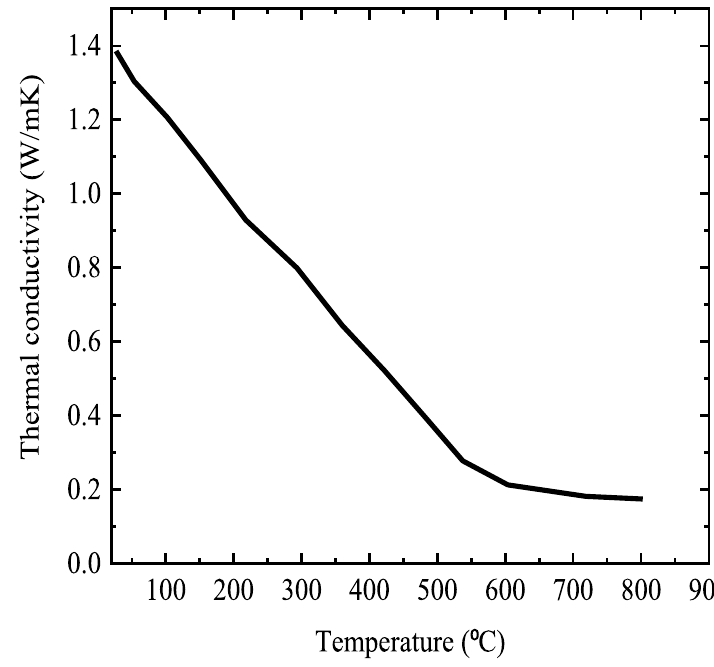
Fig. 26 Thermal conductivity of GFRP bar [27]